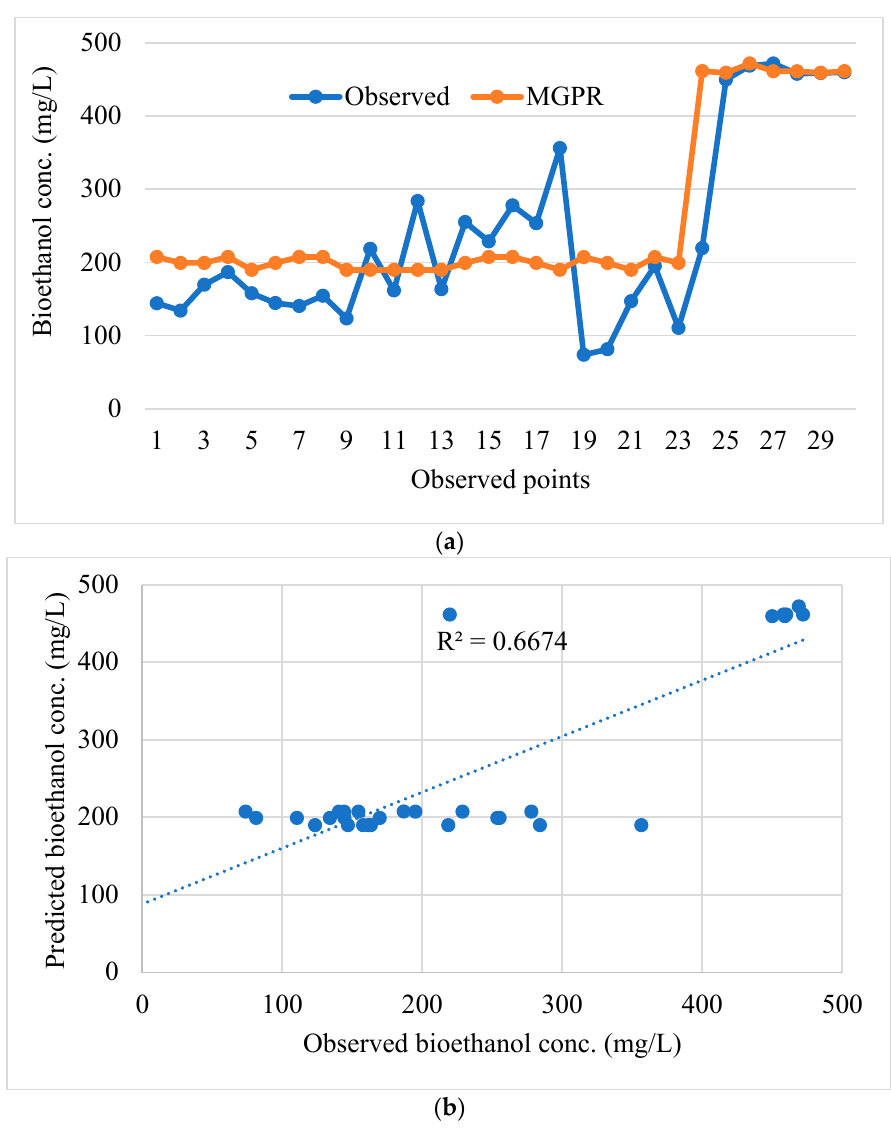
Figure 4. ( a ) Dispersion plots showing the comparison between the actual and the MGPR predicted bioethanol. ( b ) Regression plots showing the observed and MGPR predicted bioethanol.